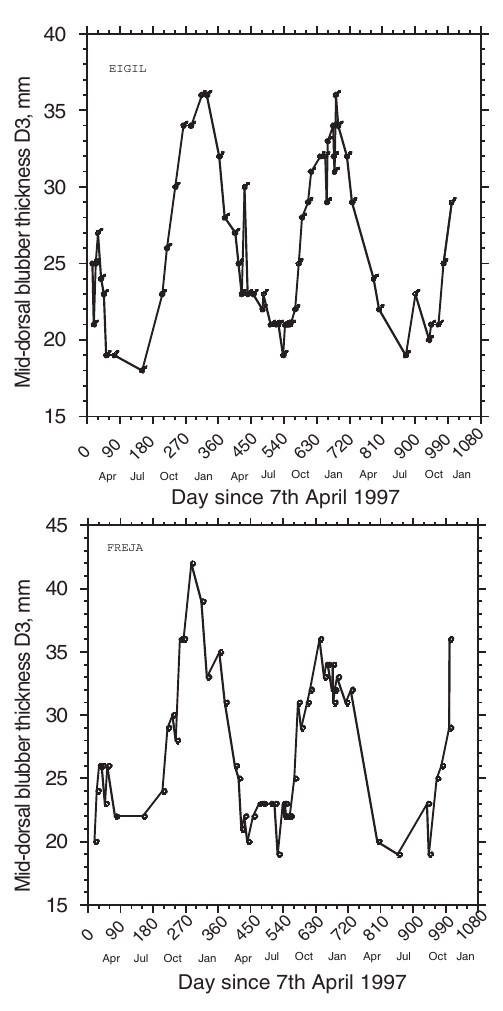
Fig. 8. Seasonal variations in mid-dorsal blubber thickness D 3 , for Eigil and